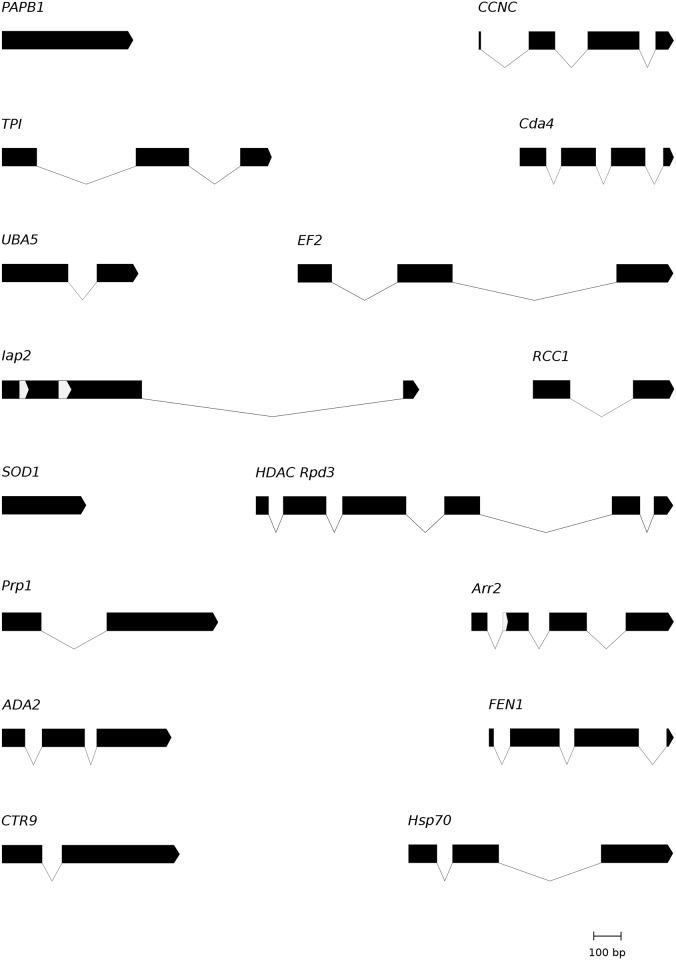
Structure of the PCR amplified gene fragments.The graphics illustrate intron-exon patterns in 16 markers with coding regions shown as black bars and introns as thin black lines. Length variable coding regions (indels) were colored in light grey (Iap2 and Arr2).